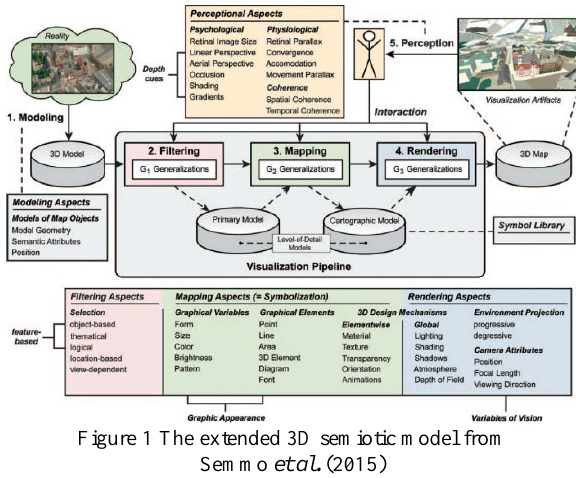
Figure 1 The extended 3D semiotic model from Semmo et al. (2015)